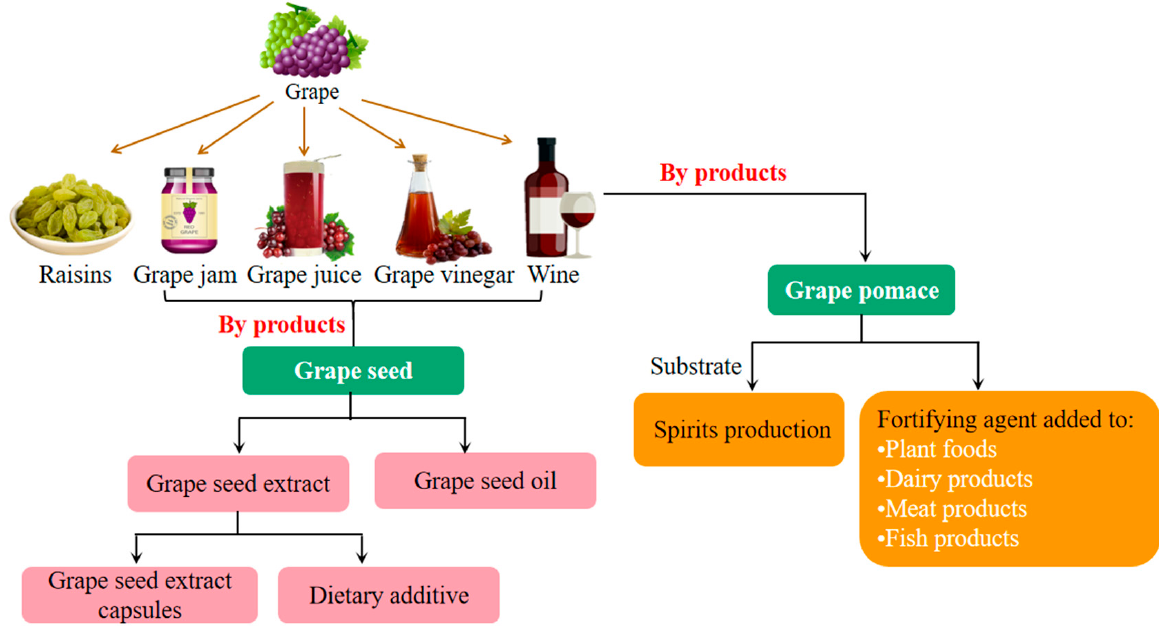
Figure 3. The applications of grape in the food industry.